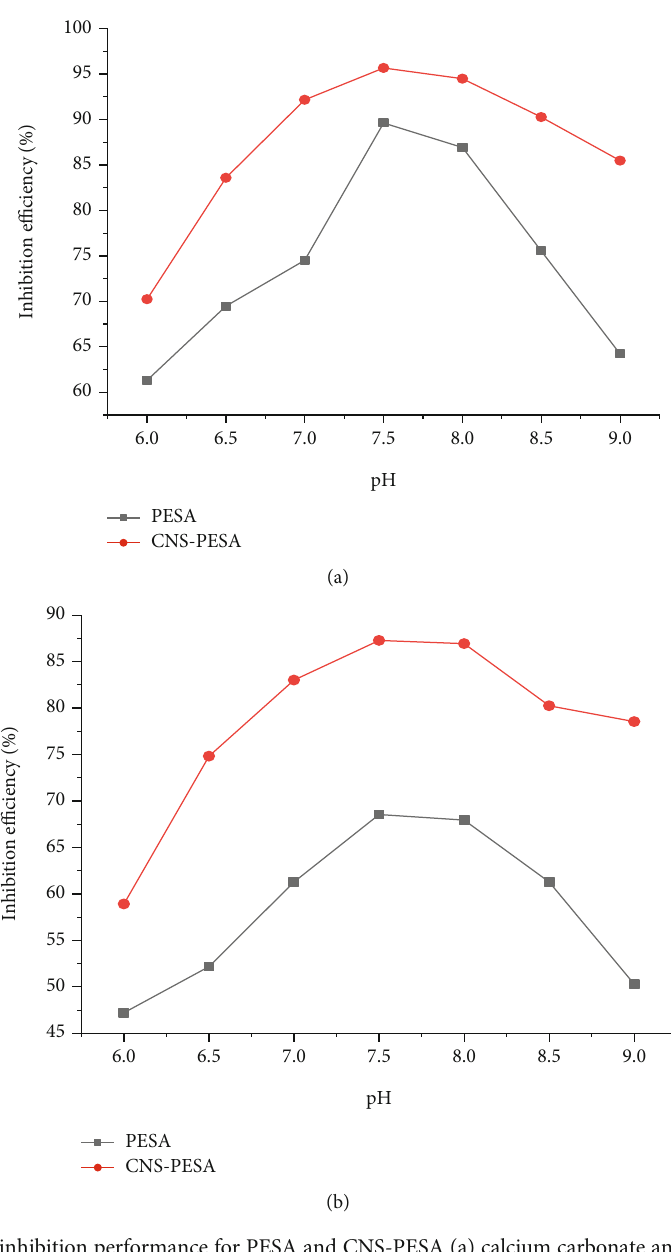
Figure 9: E ff ect of pH on scale inhibition performance for PESA and CNS-PESA (a) calcium carbonate and (b) calcium phosphate scale at di ff erent